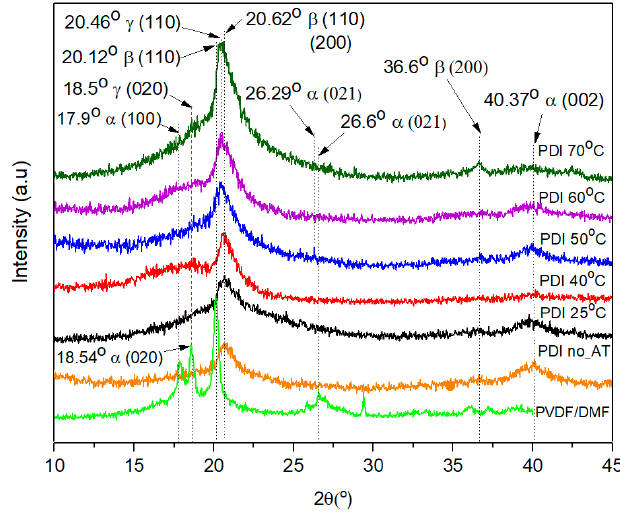
Figure 5. X-ray diffraction pattern of PVDF samples at different water temperatures. Figure 5. X-ray di ff raction pattern of PVDF samples at di ff erent water